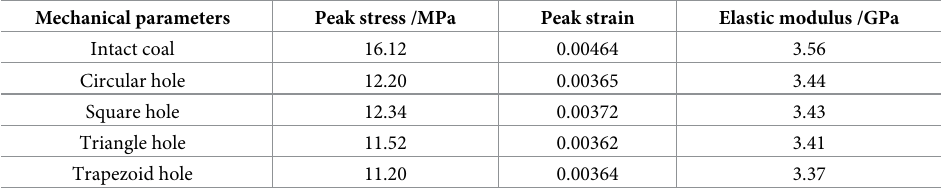
Table 3. Mechanical parameters of coal and rocks with varying shaped holes